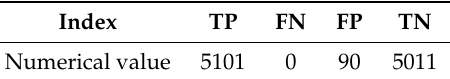
Table 16. Forecast indices value.